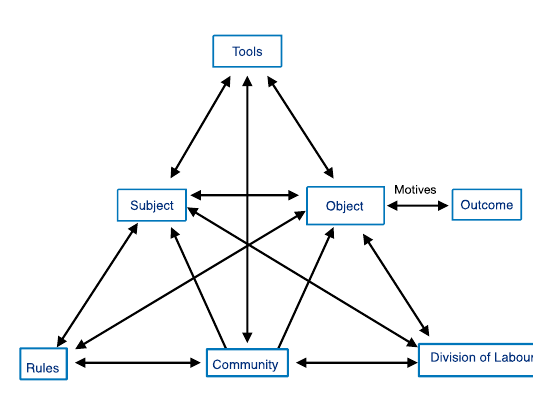
Figure 1. Activity system